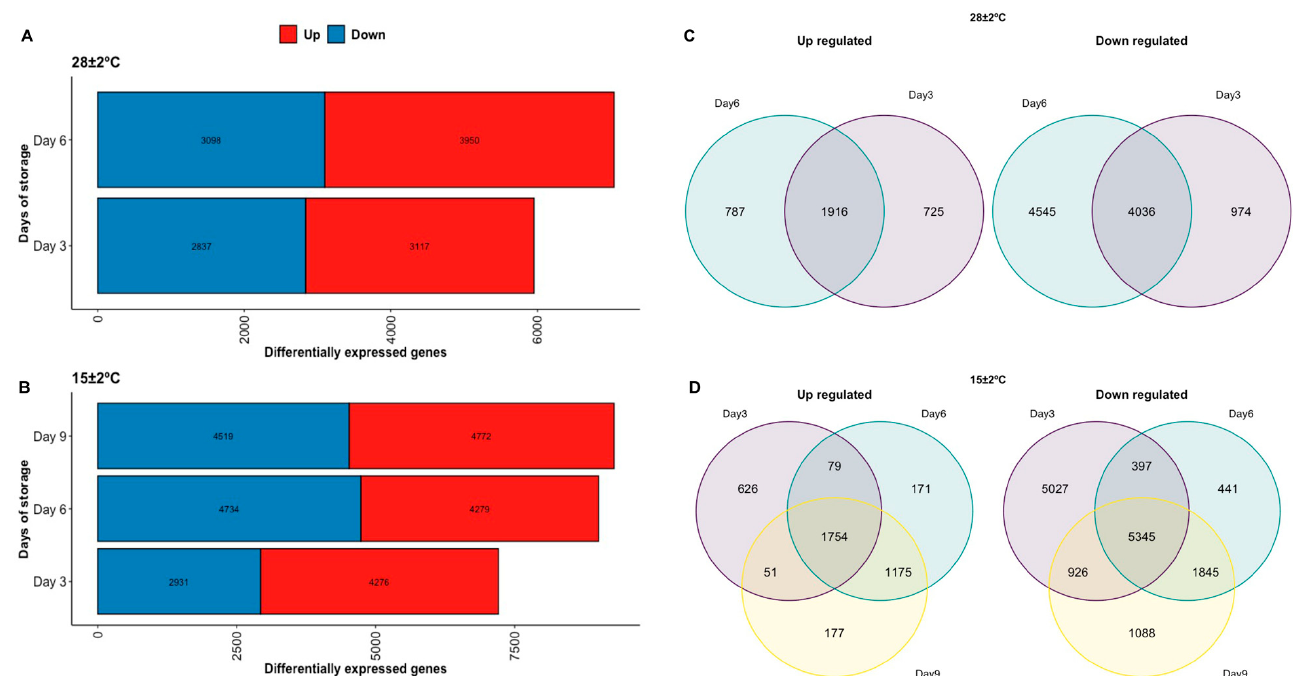
Figure 4. DEG under different temperatures ( A ) Up and down-regulated genes per day of storage at 28 ± 2 ◦ C. ( B ) Up and down-regulated genes per day of storage at 15 ± 2 ◦ C. ( C ) Venn Diagram of shared up and down-regulated per day of storage at 28 ± 2 ◦ C. ( D ) Venn Diagram of shared up and down-regulated per day of storage at 15 ± 2 ◦